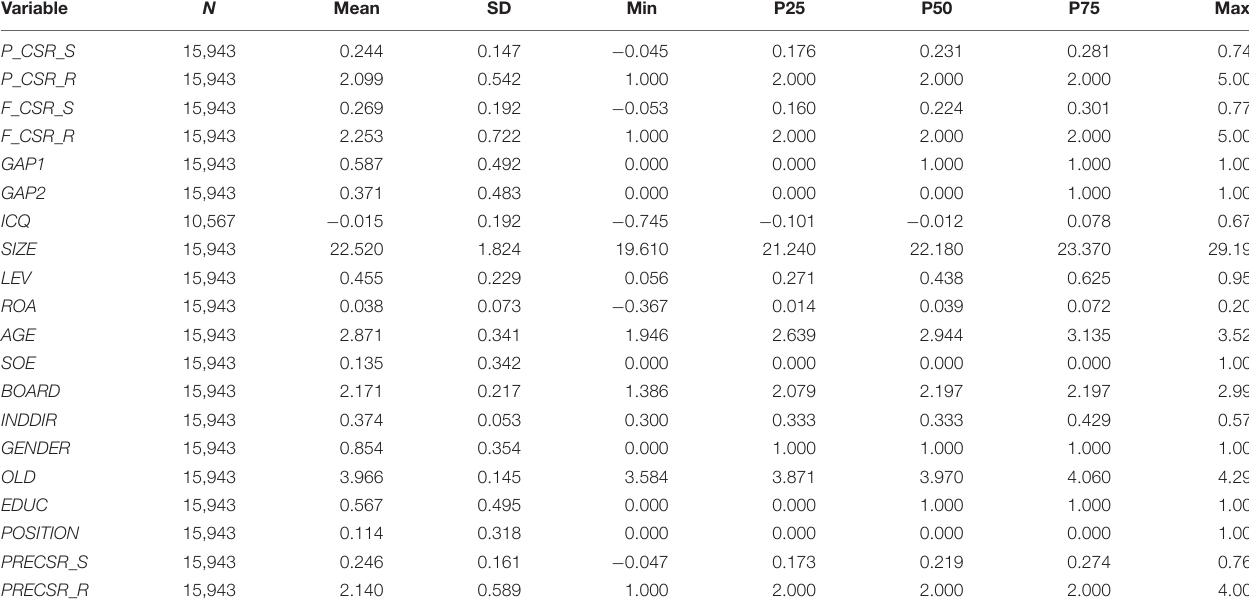
TABLE 3 | Summary